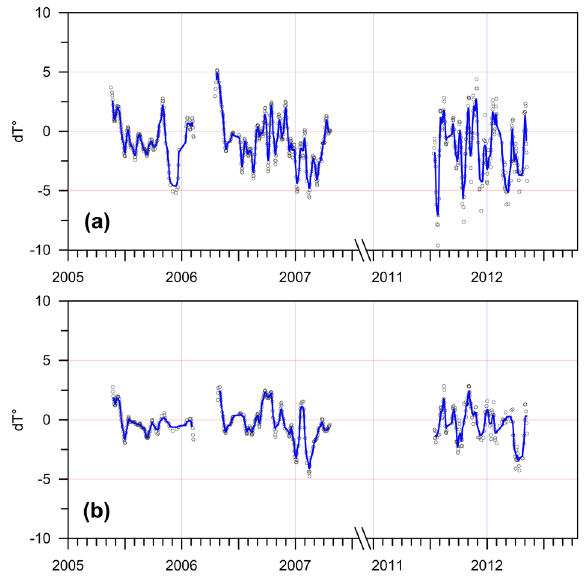
Figure 9. Relative temperature variations (dT) for 2 v (a) and 1 v (b) IR image time series. Circles and line represent one and two-pass 7 samples moving averaged time